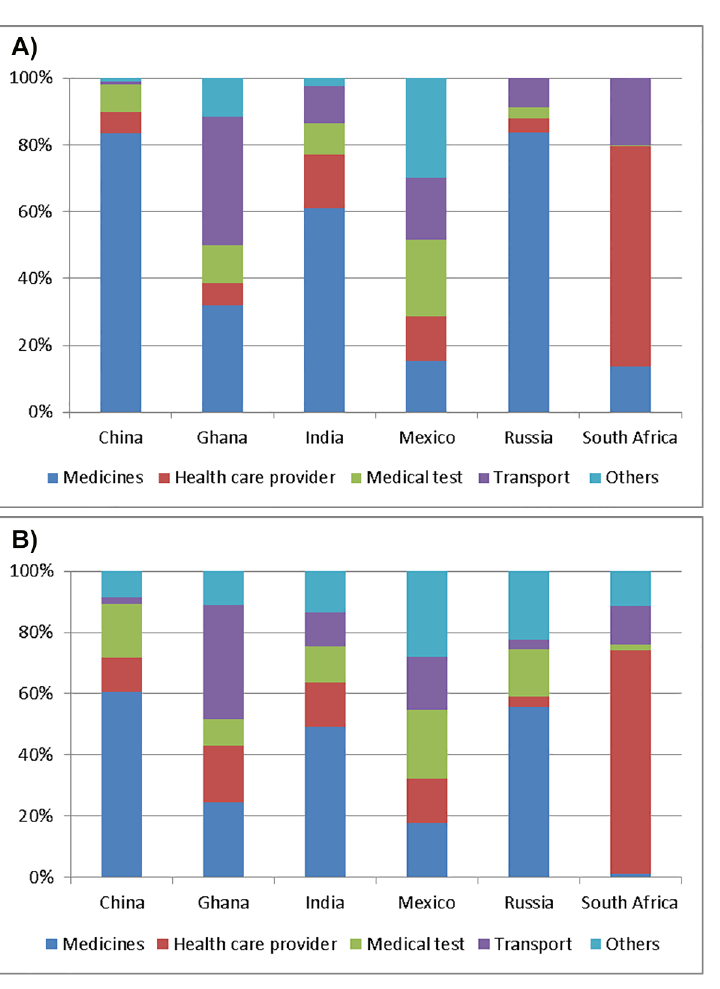
Fig 5. Percentage of out-of-pocket spending for each type of outpatient service in persons with multimorbidity (Fig 5a); Percentage of out-of-pocket spending for each type of inpatient service in persons with multimorbidity (Fig 5b). Estimates presented here are based on respondent ’ s healthcare visit that was not free of